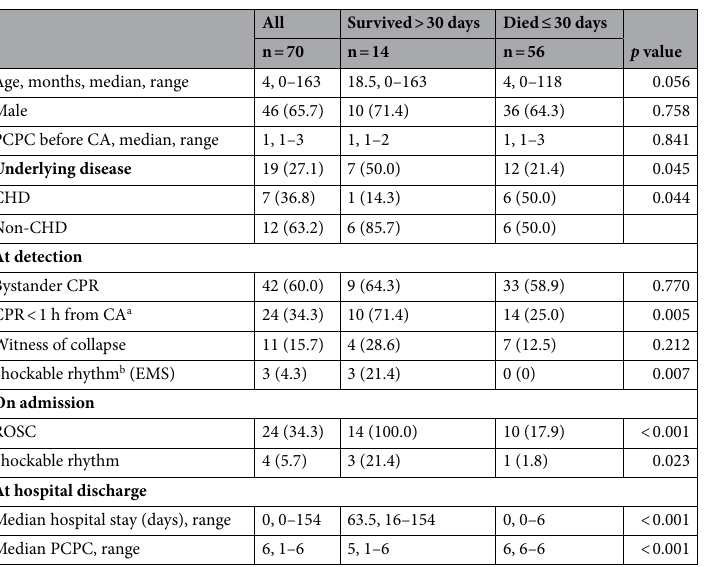
Table 1. Demographics of the study population. Percentages are shown in parentheses. EMS, emergency medical service; PCPC, Pediatric Cerebral Performance Category; CA, cardiac arrest; CHD, congenital heart disease; CPR, cardiopulmonary resuscitation; ROSC, return of spontaneous circulation. a Within 1 h between the detection of CA or the last observation of usual conditions and CPR. Data were unavailable for two deceased patients. b Shockable rhythm (ventricular tachycardia or fibrillations) detected by